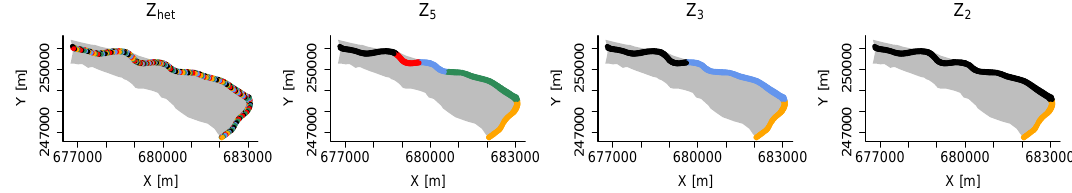
Fig. 3. Spatial representation of heterogeneity for four parameter ensembles. In the fully heterogeneous case ( Z het ) an individual leakage coefficient is assigned to each river node. For the zonated ensembles ( Z 5 , Z 3 and Z 2 ) each colour corresponds to a separate leakage zone. The river nodes within a leakage zone share the same leakage